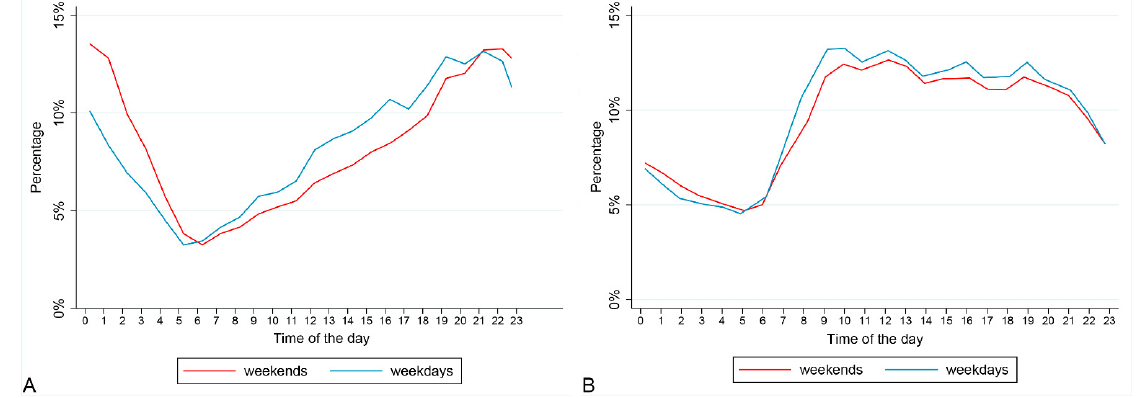
Figure 2. Distribution of alcohol-related callouts (panel A ) and non–alcohol–related callouts (panel B ) during hour of the day by weekend and weekdays.